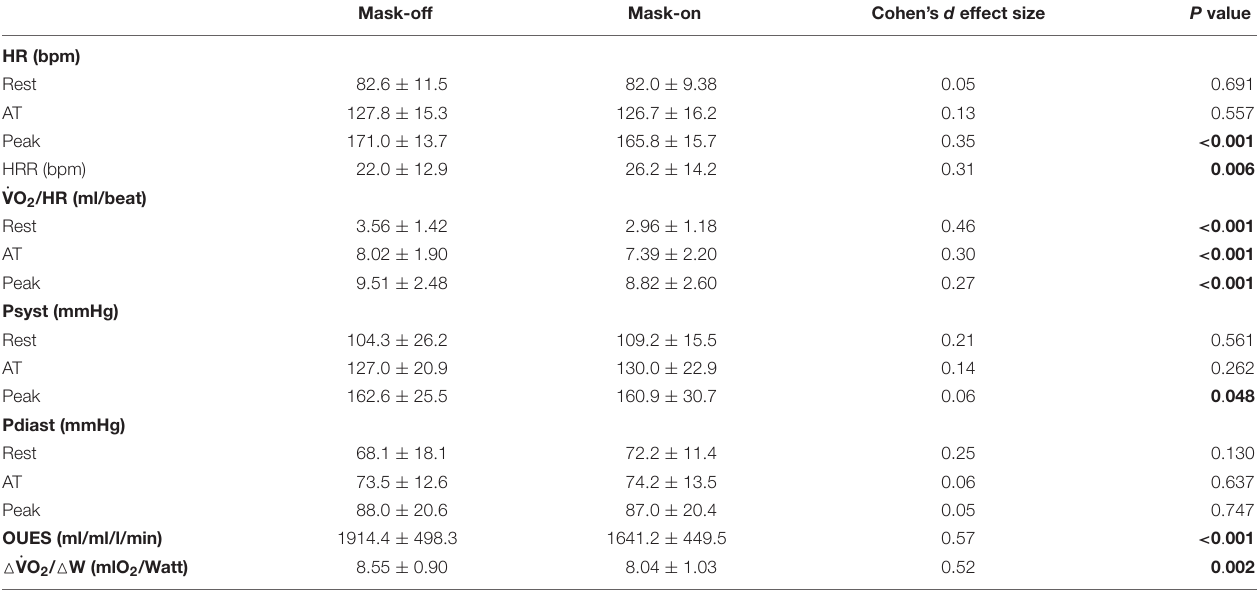
TABLE 5 | The comparison of cardiovascular reaction parameters between mask-on and mask-off condition. Mask-off Mask-on Cohen’s d effect size P